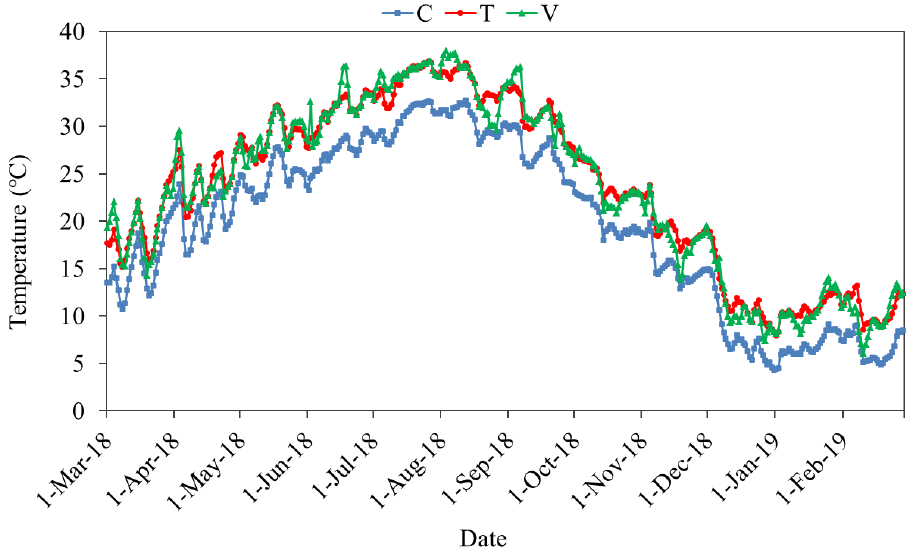
Figure 1. Water temperature for all treatments during the experiment. C, ambient temperature; T, +4 °C constant warming; V, variable warming.